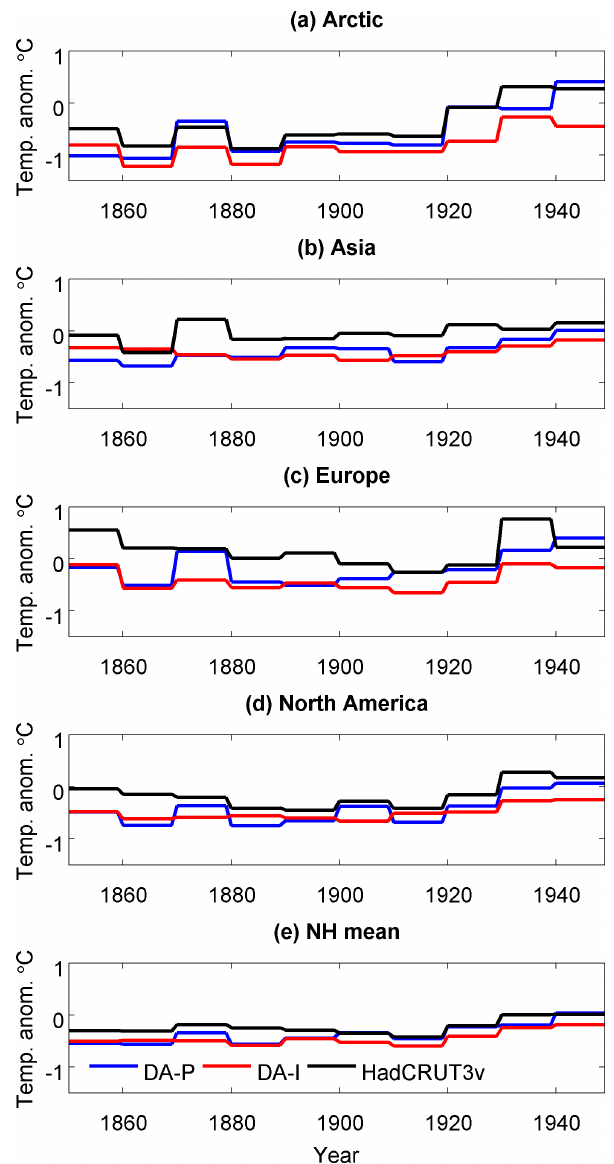
Figure 3. NH continental and mean decadal temperature anomalies for the DA-P analysis (blue), DA-I analysis (red) and the instrumen- tal data (black). The reference period is 1961–1990